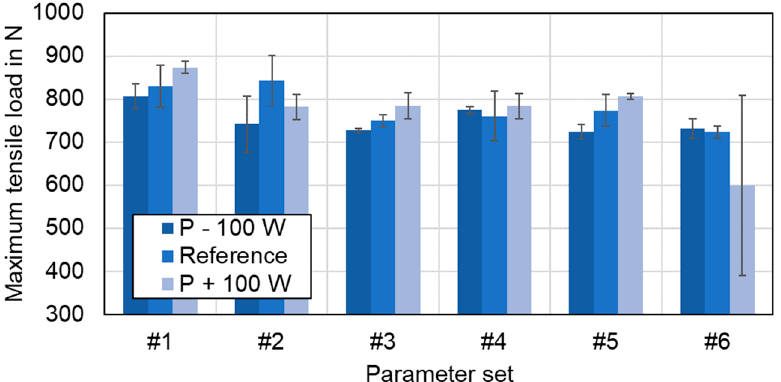
Figure 27. Comparison of tensile-shear strength results for parameter sets #1–#6 and variation of the laser power.